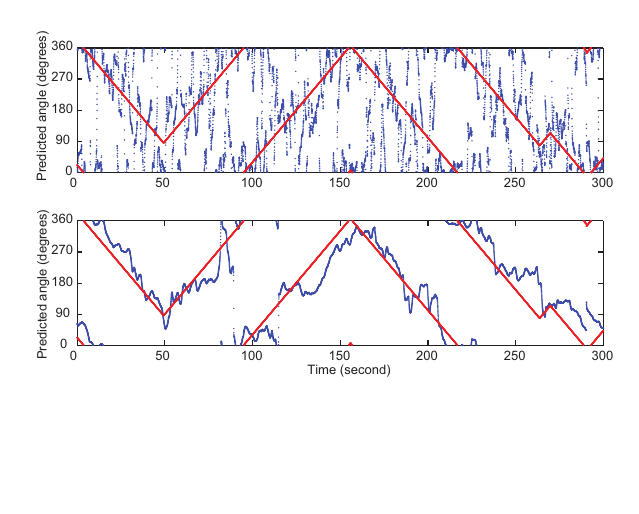
track the direction of a target moving on a circle while fixating at the central cross. (C) The directions of attention were arbitrarily divided into 16 subparts and the respective alpha power was estimated using at 275 sensor MEG system. The topography of the alpha band activity is clearly modulated by the direction of attention. (D) The direction of covert attention was estimated from 1700 ms data segments. The true angle of the target could be predicted from the alpha activity alone with some error (top panel). After a smoothness constraint was applied (lower panel), the prediction error was much reduced. [ (B,C,D), top panel] Reproduced with permission from Bahramisharif et